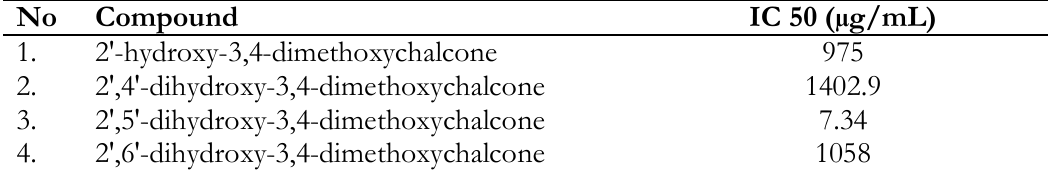
Table II. IC 50 of derivatives of hydroxy chalcone